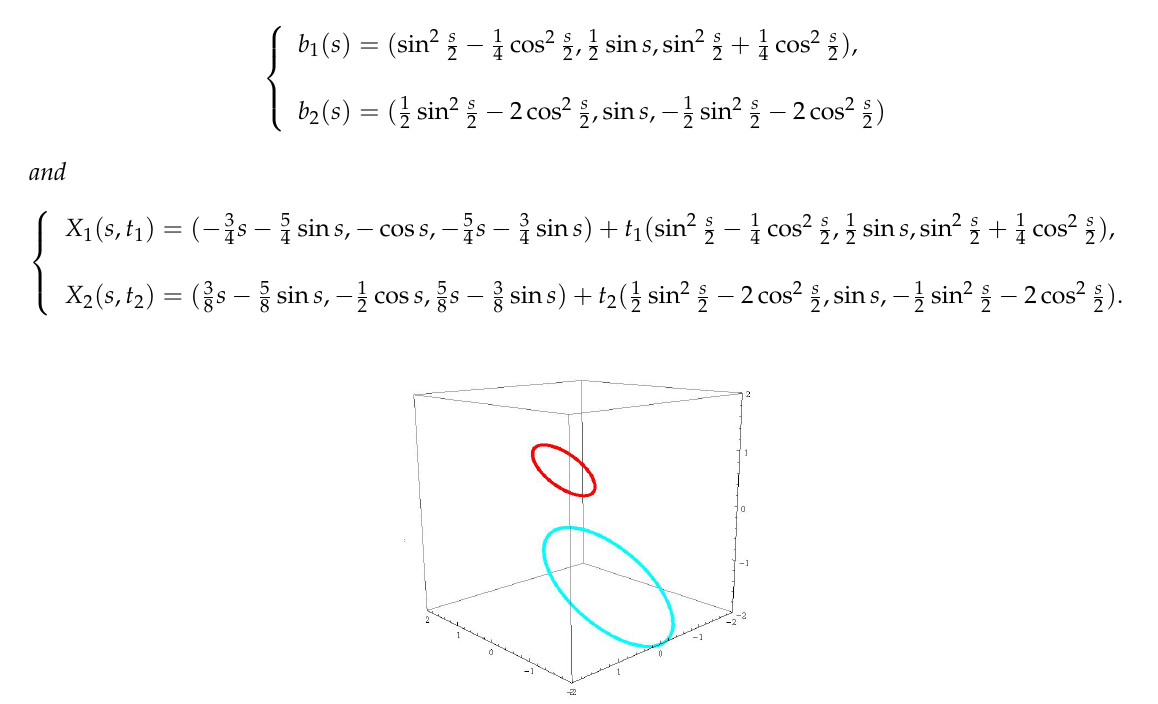
Figure 5. The red (blue) curve is the generalized T ( B ) -associate curve b 1 ( b 2 ) of r .